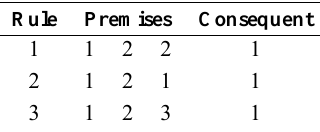
Table 3: Example 1: Set of candidate rules to be compacted. Rule Premises